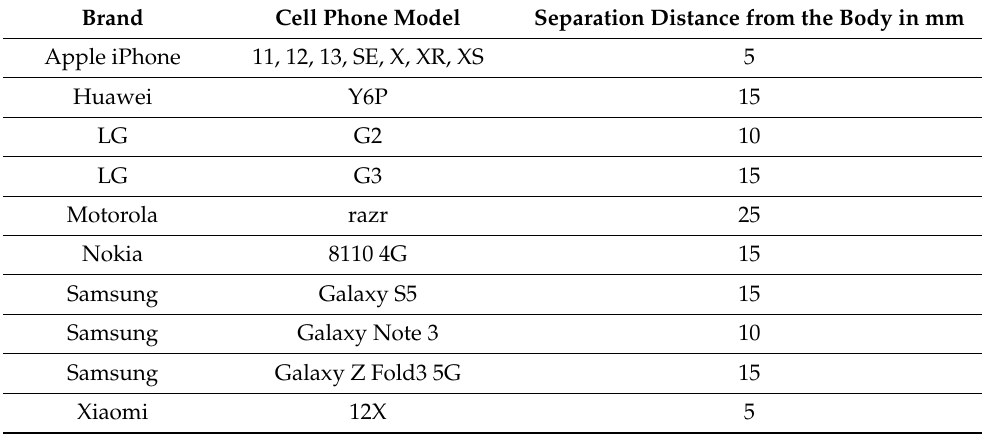
Table 3. Cell Phone Manufacturers’ Recommended Body Separation